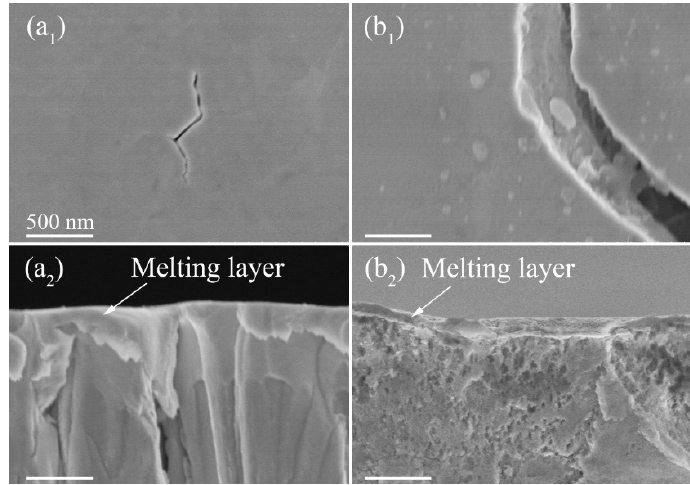
Figure 6. The SEM surface and cross-sectional images of the W-150W-10 film ( a 1 , a 2 ) and bulk W ( b 1 , b 2 ) irradiated by HIPIB with an energy density of 1 J/cm 2 and pulses of 10. The corresponding scale is uniform.